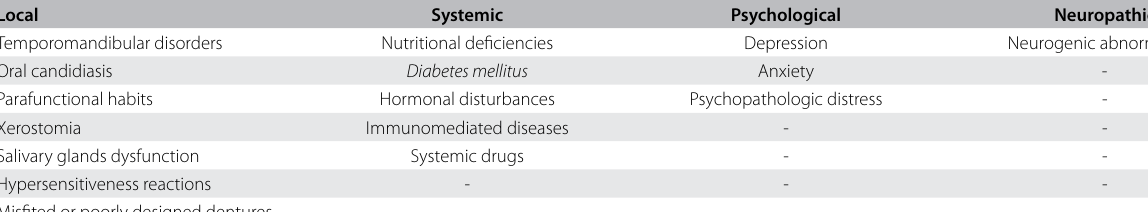
Table 2. Factors associated with the etiology of burning mouth sensation